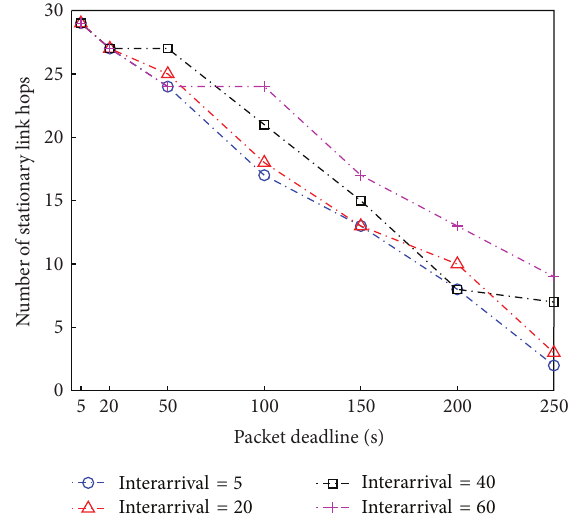
Figure 4: The number of stationary link hops with respect to packet deadline and mobile nodes’ interarrival